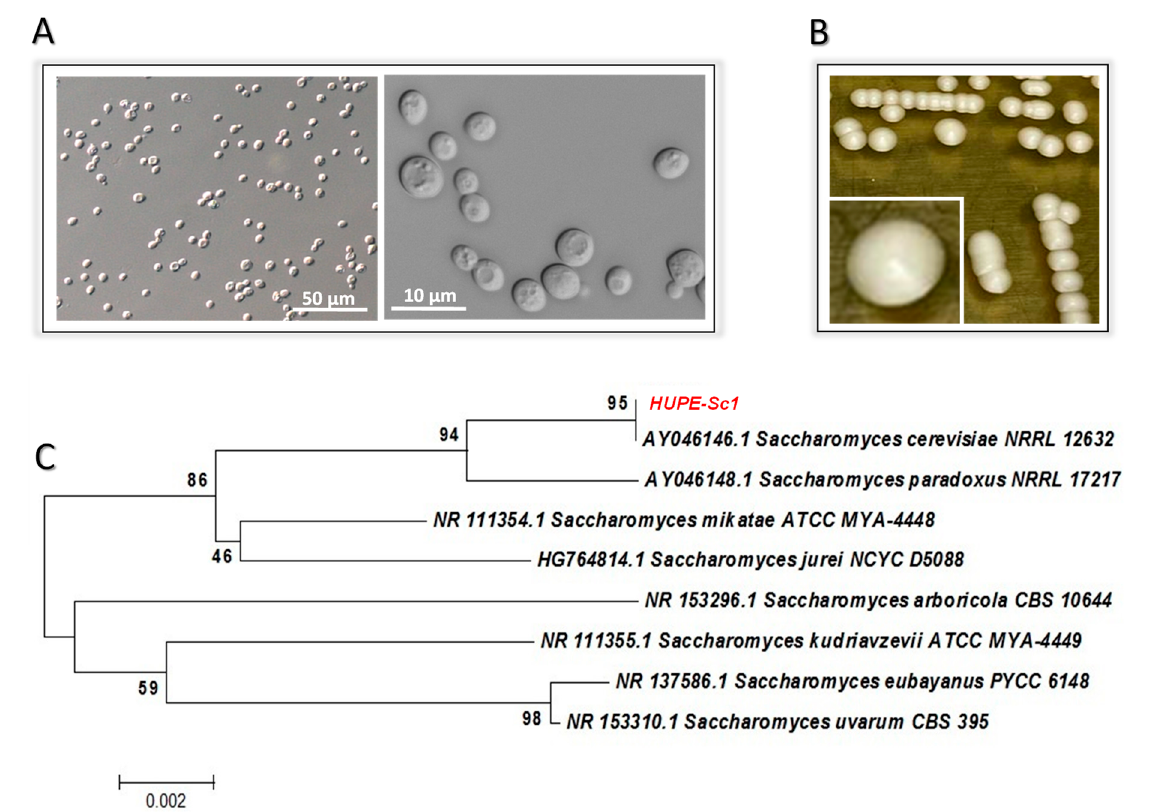
Figure 1. Microscopic ( A ) and macroscopic ( B ) aspects of S. cerevisiae HUPE-Sc1 strain grown for 48 h at 37 °C on Sabouraud dextrose agar. ( C ) Phylogenetic neighbor-joining dendrogram generated from a genetic similarity matrix based on comparison of ITS1-5.8S-ITS2 gene sequences from HUPE-Sc1 strain and type strains belonging to the Saccharomyces genus; sequences were obtained from GenBank database.